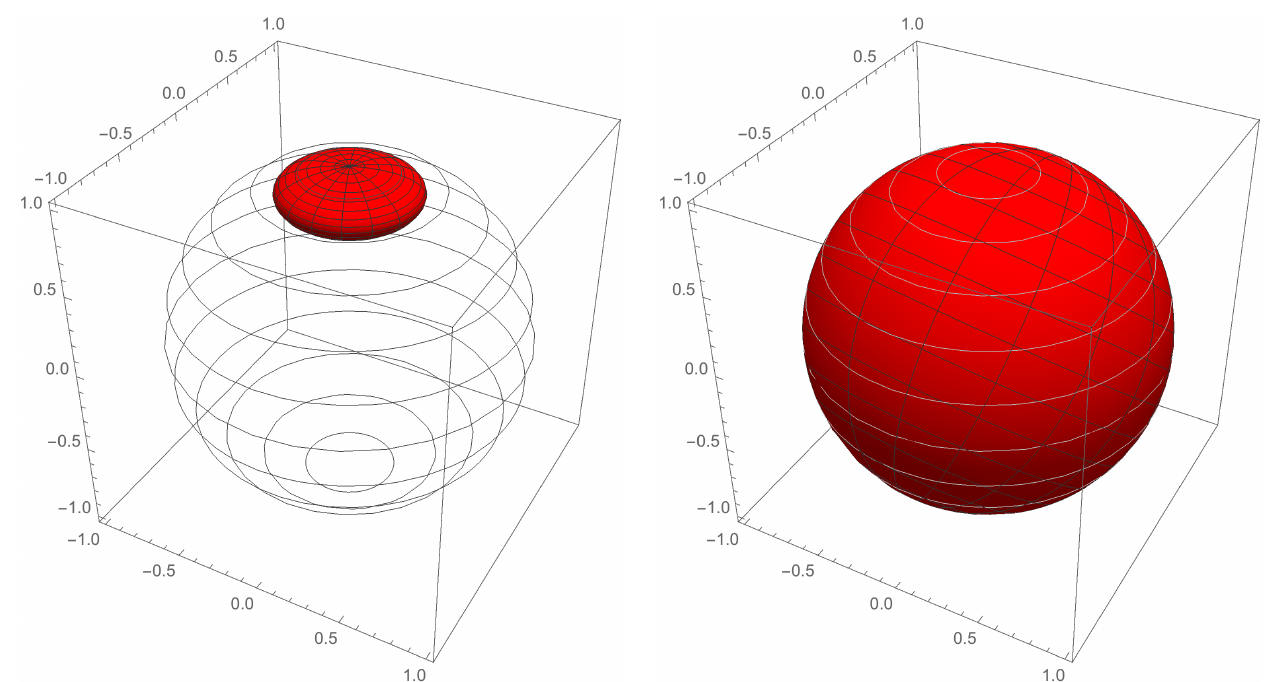
Figure 4: Action of unitary on the Bloch ball. The Bloch ball gets mapped to itself. The image is plotted in